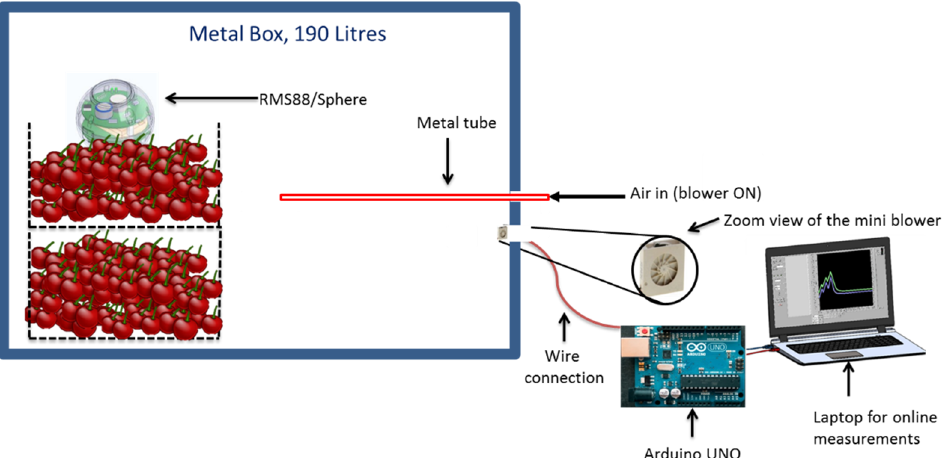
Figure 1. The experimental setup used for evaluating the effect of forced airflow on the mass transfer coefficient in a 190 L metal box connected to a metal tube (different diameters and lengths). A 12 mm × 12 mm × 3 mm blower with the flow rate of 2.7 L min − 1 operated by an Arduino UNO was installed in an opening of the box to facilitate forced airflow. Changes in the O 2 and CO 2 concentrations were measured using a modular sensor system (RMS88) that transferred data in real time to the gassensor software on a